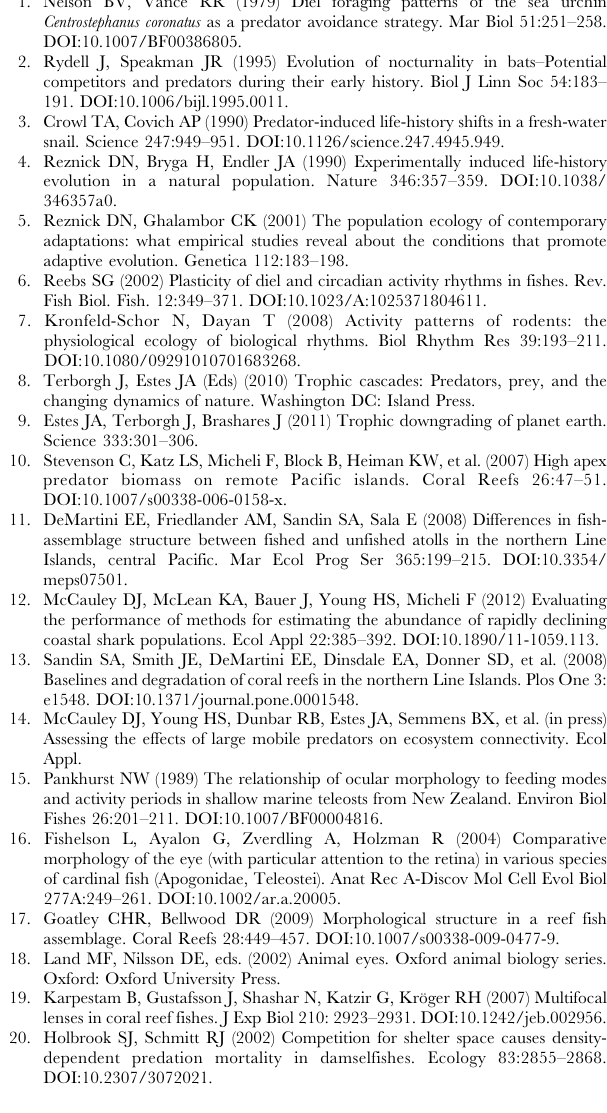
Fig. 3 courtesy of: 3A/C Florent Charpin; 3B Jenny Huang; 3D Alain Feulvarch. For assistance with data collection and analysis we thank Gerald Allen, David Catania, Paul DeSalles, John McCosker, Robert Myers, Lauren Palumbi, and John Randall. Useful advice on this manuscript was provided by Steve Palumbi and Jim